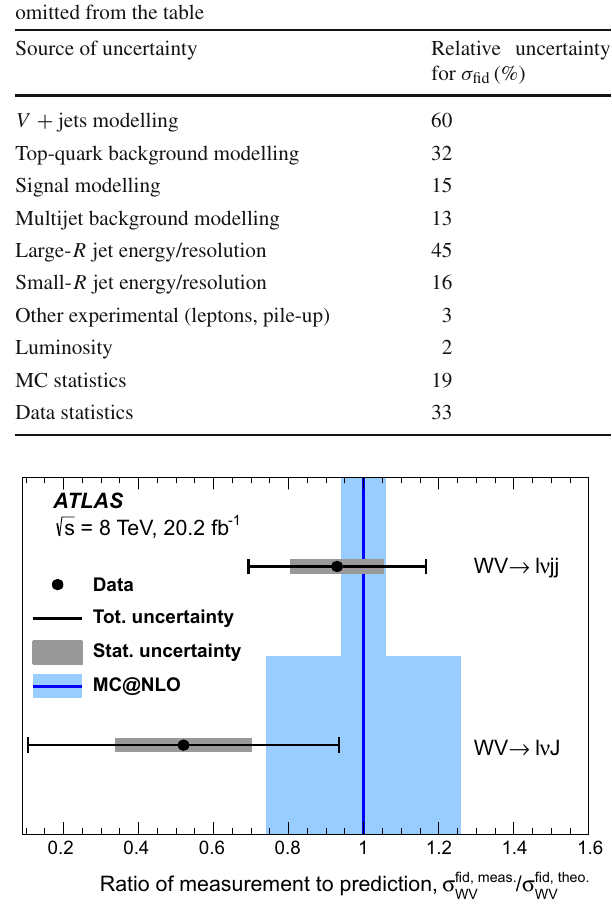
Table 4 Breakdown of the uncertainties in the measured fiducial cross- section in the WV → (cid:4)ν J channel. Uncertainties smaller than 1% are